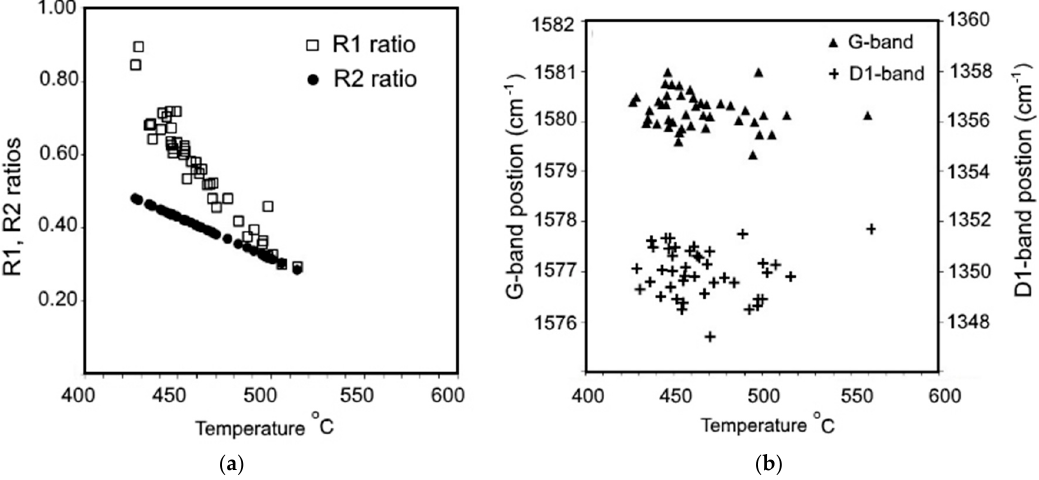
Figure 6. Temperature measurement results from Raman spectroscopy such as: ( a ) intensity ratio (R1) and area ratio (R2); ( b ) D1 and G bands positions.